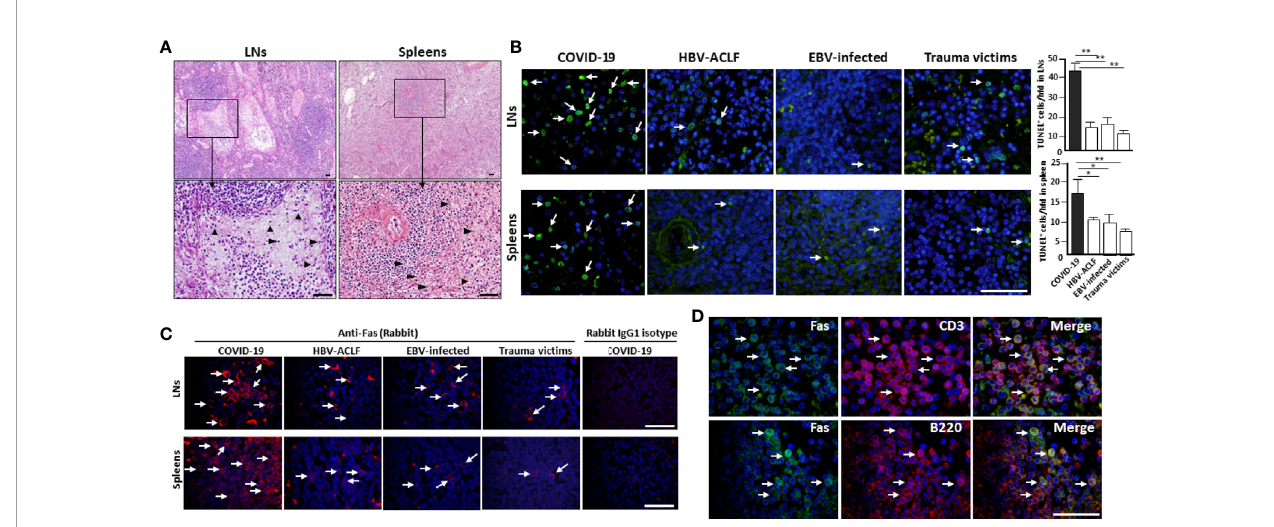
FIGURE 1 | SARS-CoV-2 destroys human spleen and LN tissues. The spleens and hilar LNs were collected from one representative fatal COVID-19 (case #2), HBV-ACLF, EBV-infected patients and trauma victim, (A) histopathology was compared by H&E staining, arrow heads show apoptotic cells; (B) cell apoptosis was detected by in situ TUNEL staining (left), with statistical analysis of apoptotic cells (right). Arrows indicate positive cells, * p < 0.05 and ** p < 0.01; (C) immuno fl uorescent staining analysis of Fas expression; (D) immuno fl uorescent double staining analysis of Fas expression by CD3 + T cells and B220 + B cells in the hilar LNs. Scale bar = 50 m M arrows indicate double positive cells.